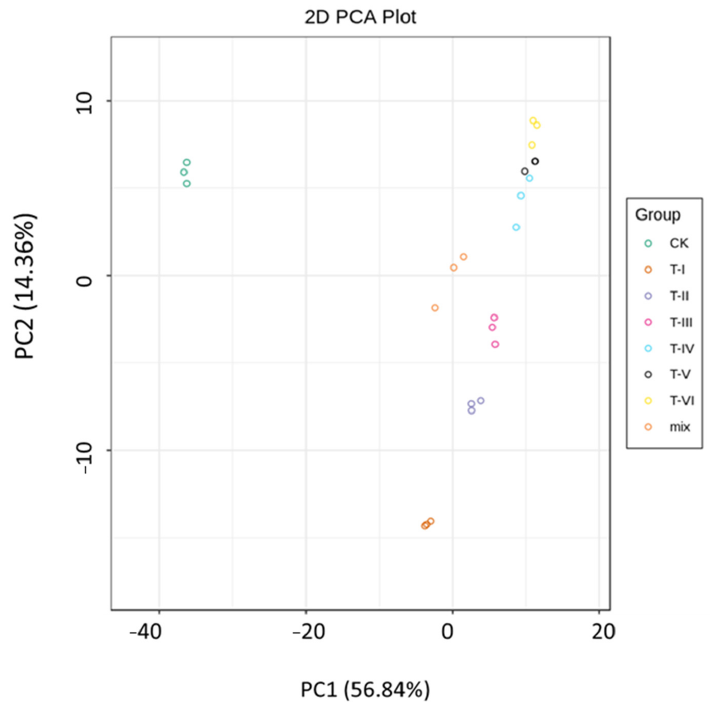
Figure 5. PCA plot showing the metabolomic difference between different groups.